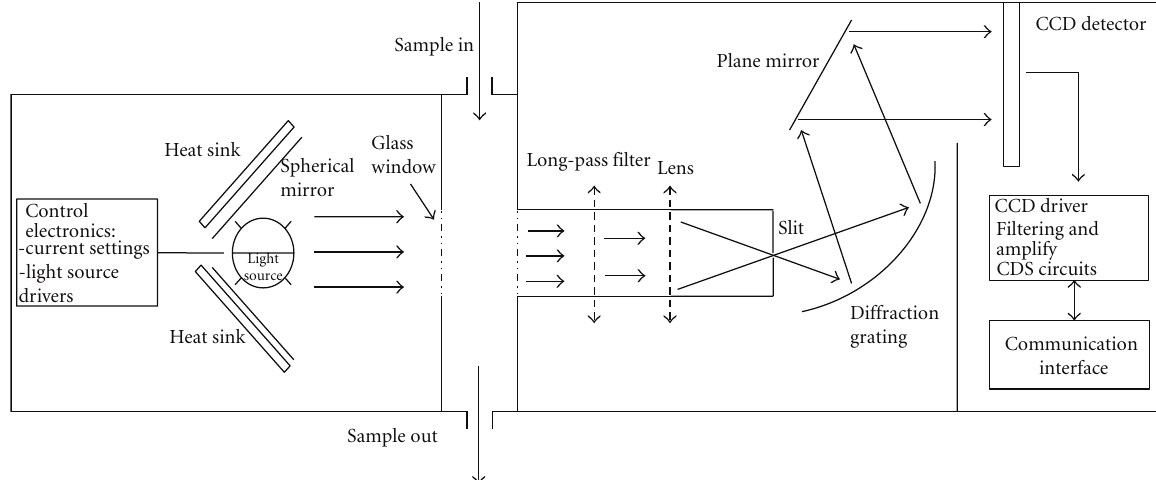
Figure 1: Schematic diagram of the multichannel SW-NIR spectrometer